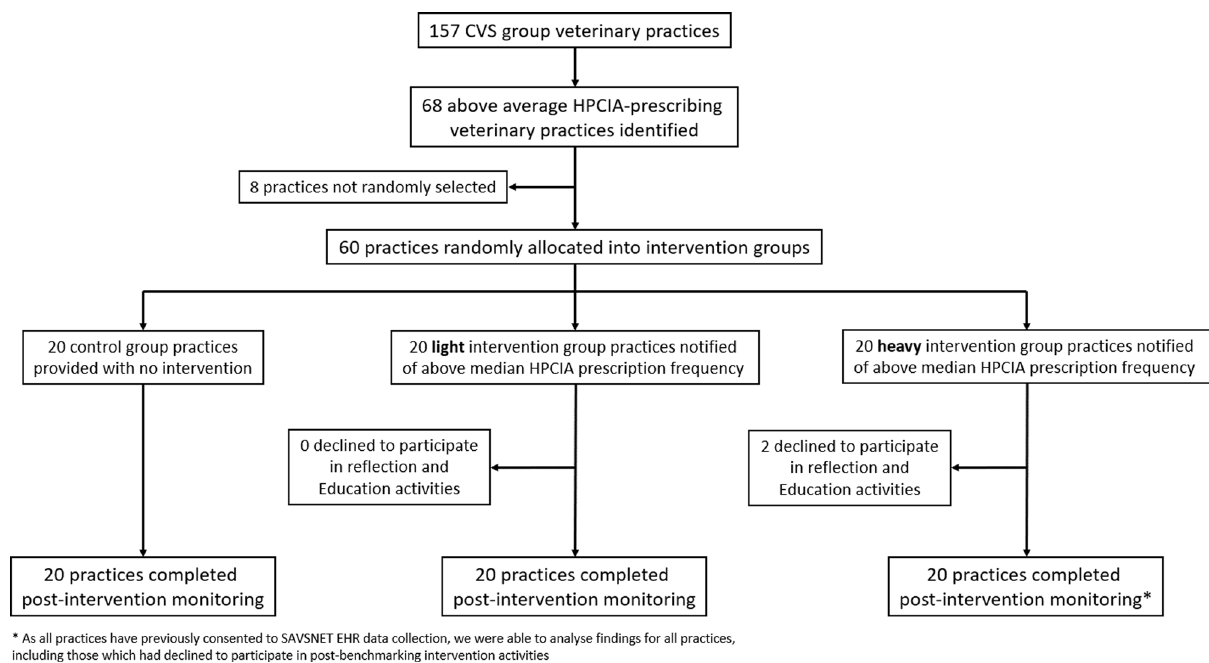
Fig. 1 Trial practice group allocation. Schematic diagram of the process used to select above average highest priority critically important antimicrobial (HPCIA) prescribing veterinary practices owned by CVS Group Limited, followed by drop-off rate following the initial benchmarking